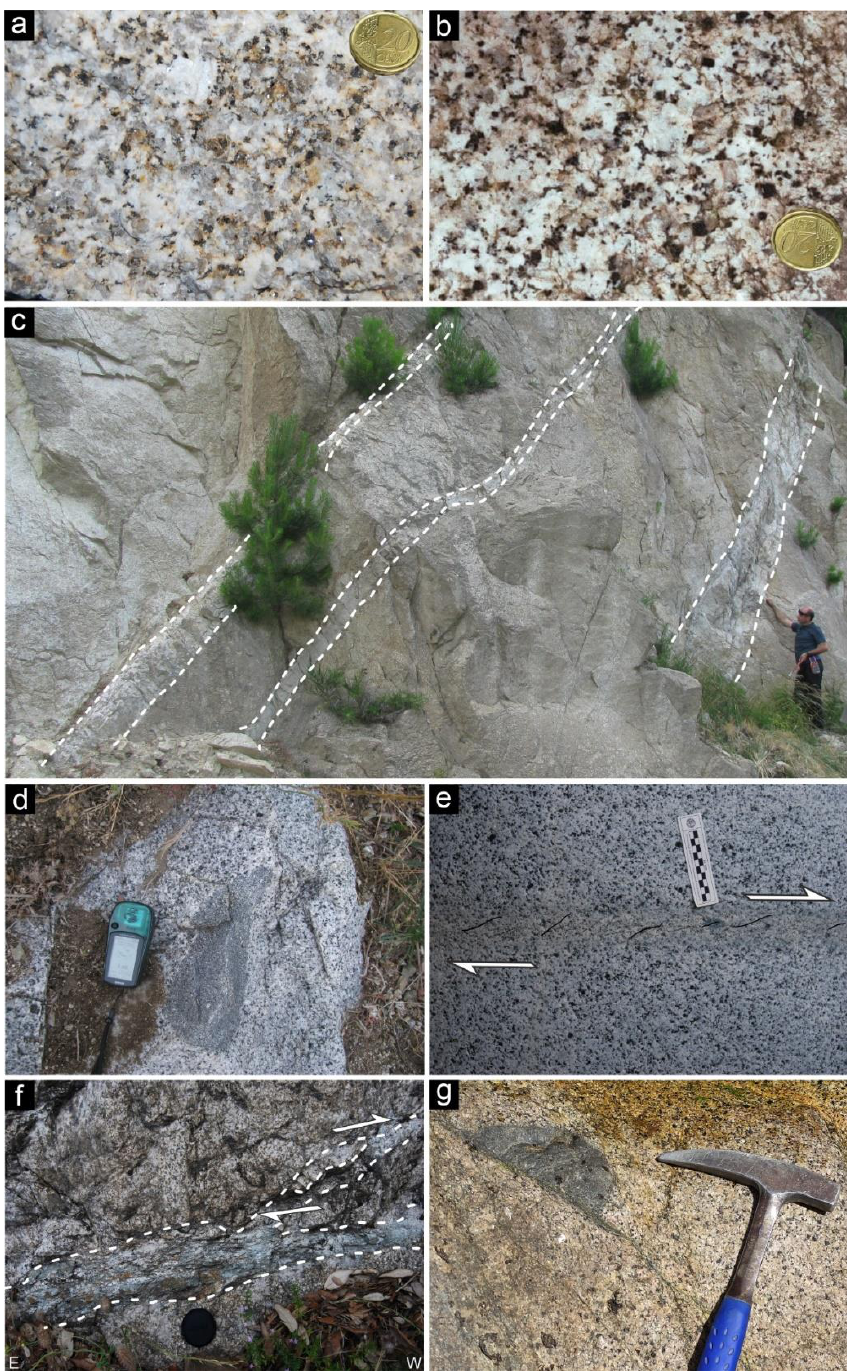
Figure 2. Typical field appearance of ( a ) MBG and ( b ) BAG; ( c ) 10 cm to a meter thick steeply dipping felsic dykes showing sharp intrusive contacts with MBG host rocks; ( d ) stretched mafic microgranular enclave in BAG; ( e ) narrow shear zone showing a dextral sense of shear within an isotropic BAG; ( f ) anastomosed shear zone with a dextral sense of shear in BAG; ( g ) mafic enclave truncated by a narrow shear zone in BAG. A weak fabric can be detected in close proximity of the tectonic structure.